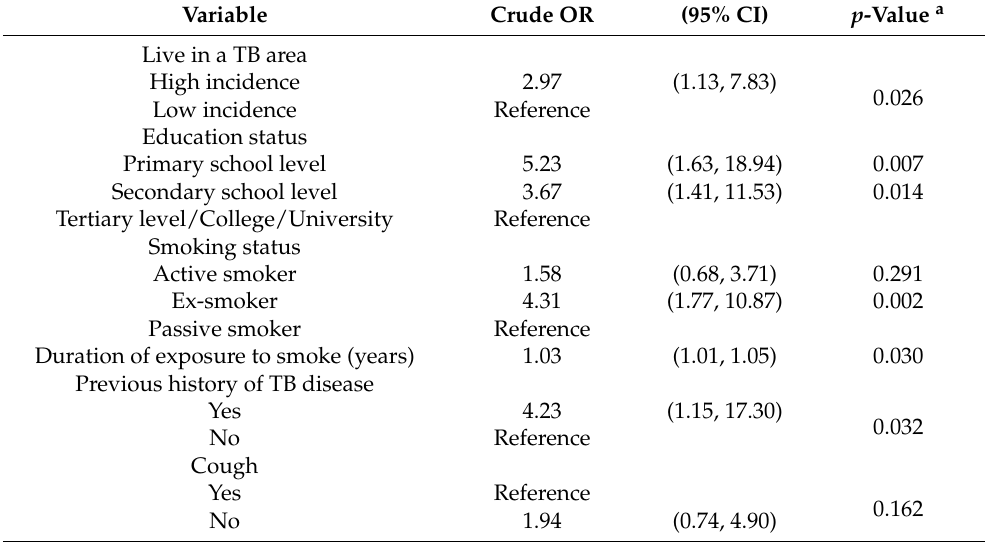
Table 2. The associated factors with TB disease among smokers in Bachok, Kelantan (n =